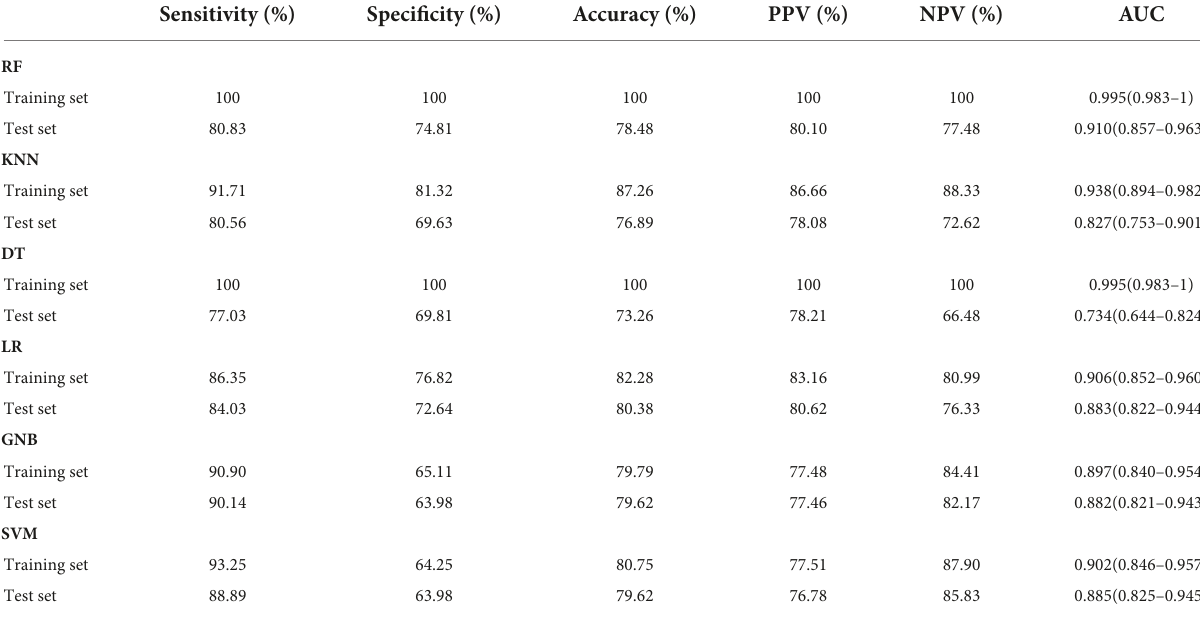
TABLE 4 Classification performance for the two-circRNA signatures between intracerebral hemorrhage (ICH) patients. Sensitivity (%) Specificity